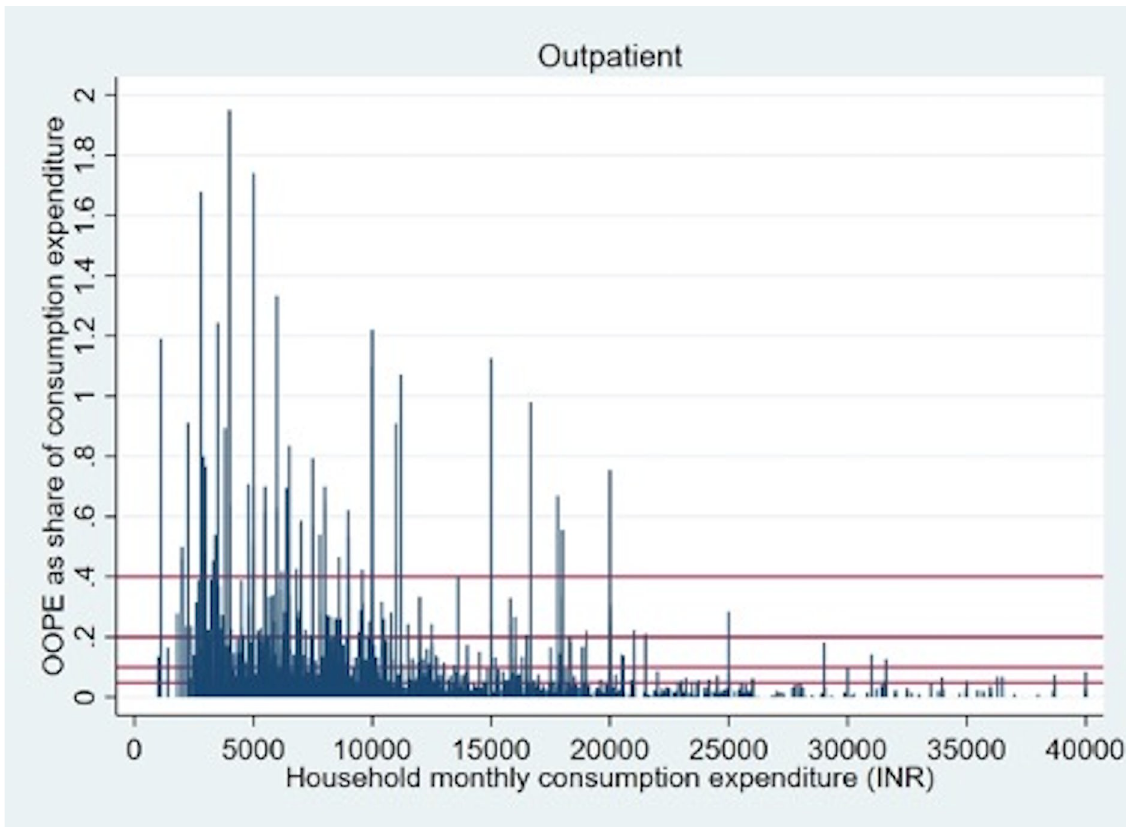
Fig 1. Outpatient OOPE on childhood infections as a share of per capita monthly consumption expenditure of households.